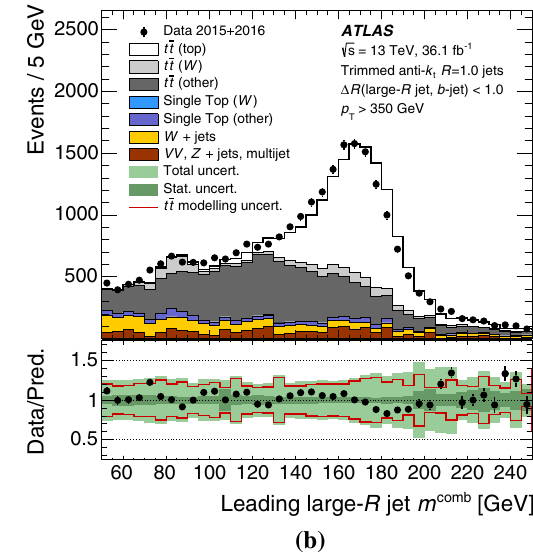
Fig. 9 A comparison of the observed data and predicted MC distribu- tions of the mass of the leading p T anti- k t trimmed jet in the event for the W boson( a )andtopquark( b )selectionsinasampleenrichedinlep- ton+jets t ¯ t events.Simulateddistributionsarenormalisedtodata.The t ¯ t sampleisdividedintoasetofsubsamples(e.g. t ¯ t (top))basedoncriteria